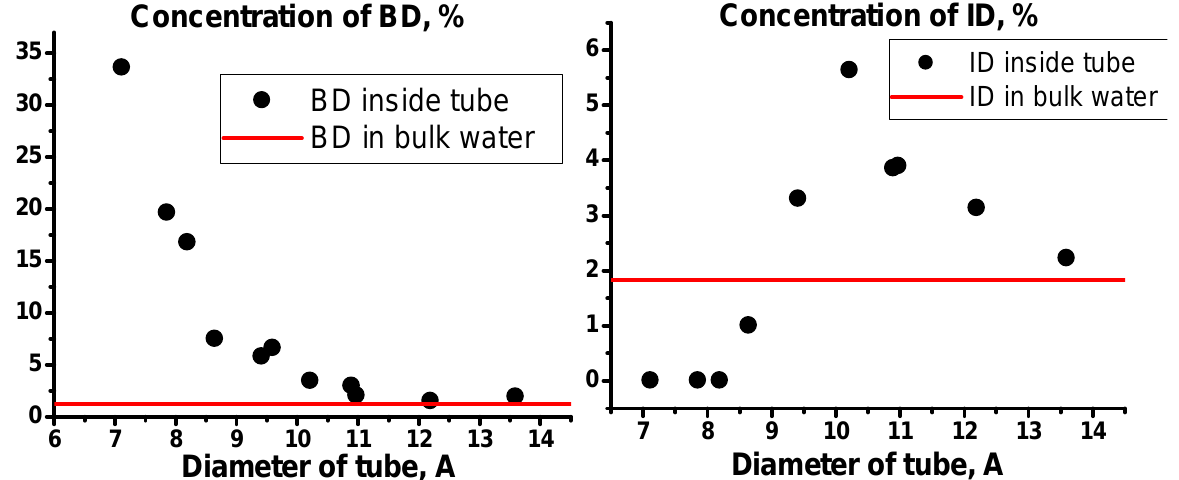
Figure 9. Dependencies of concentrations of BD and ID for inner and bulk water on the CN